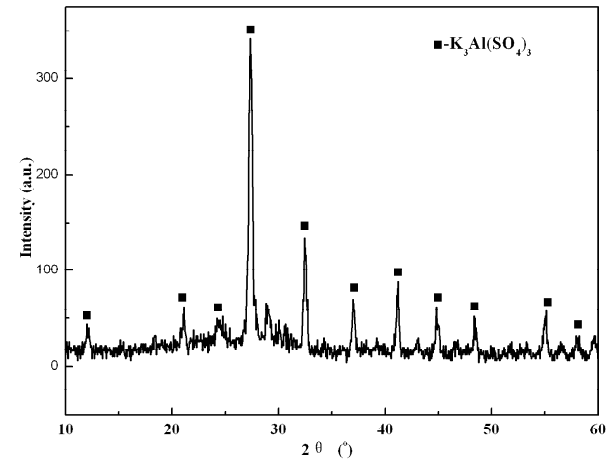
Figure 6. X-ray diffraction (XRD) patterns of products calcined at 230 °C with a KHSO 4 /Al 2 O 3 molar ratio of seven for 3 h.